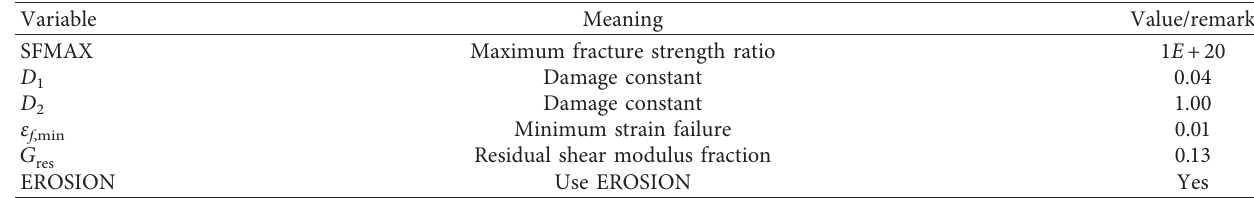
Table 4: RHT failure model input parameters for C-35